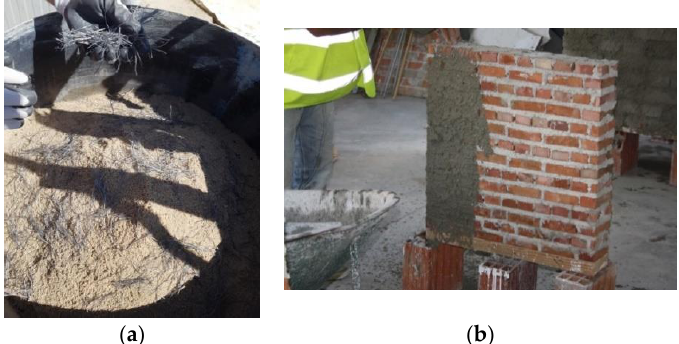
Figure 11. Reinforcement preparation: ( a ) mixing polypropylene fibers with sand and ( b ) application.